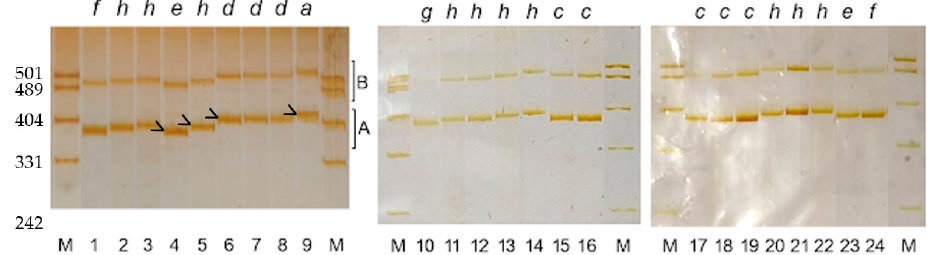
Figure 3. PCR product length polymorphism (GliB1.2 primers) among wheat cultivars. 1, Galahad; 2, Krasnodonka; 3, Caia; 4, Glenlea; 5, Ardec; 6, Laura; 7, Suneca; 8, Inia-66; 9, Chinese-Spring; 10, Argelato; 11, 12, Krasnodonka; 13, Ardec; 14, Caia; 15, Siete-Cerros-66; 16, Cappelle-Desprez; 17, Diego; 18, Prinqual; 19, Siete-Cerros-66; 20, Krasnodonka; 21, Ardec; 22, Caia; 23, Escualo; 24, Arminda. Alleles at the Gli-B1 locus are indicated above lanes. M, marker pUC19 / Mspl, with DNA fragment lengths in bp given on the left-side of the figure. The four principal variants are signalled by > in the left-hand panel of the